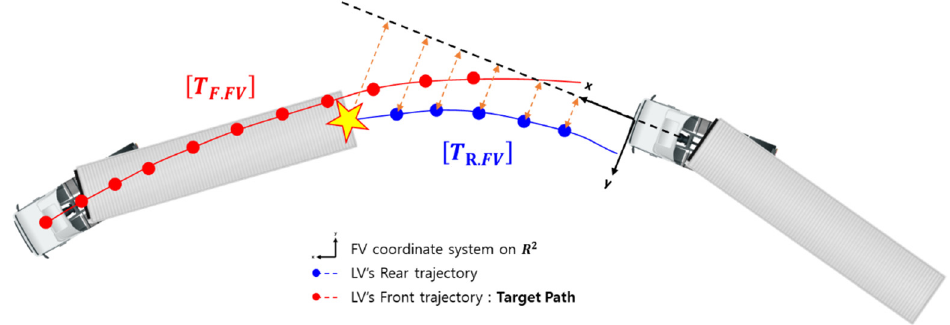
Figure 16. LV trajectory defined in the FV coordinate system.